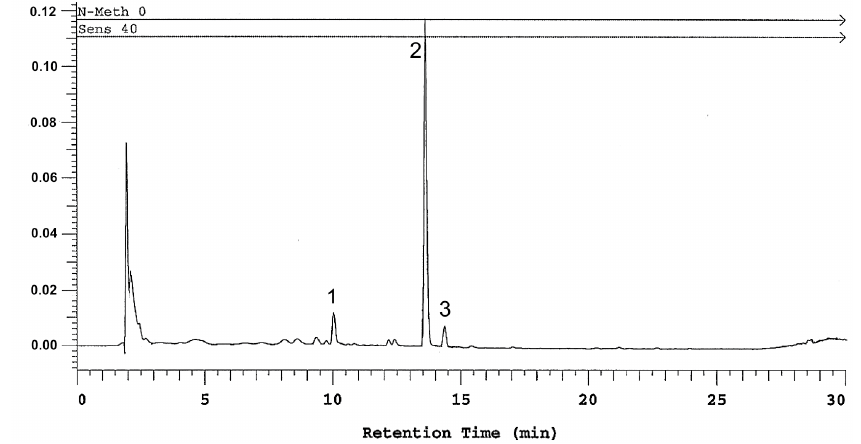
Figure 7. Results of RP-HPLC analysis (detection wavelength 258 nm) of the xanthone enriched fraction from the ethanolic rhizome extract of Anemarrhena asphodeloides , the peaks represent: